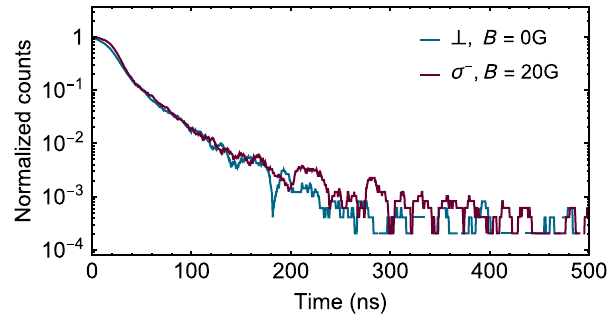
FIG. 8. Photon-count decay with a linear polarization, no magnetic field, and no optical pumping, i.e., multilevel situation (blue). The same is shown for the two-level case: 20-G magnetic field, σ − polarization, and prior optical pumping (purple). The two traces have been normalized to the steady state, with measurements for N ≃ 4500 in the first trapping geometry (see Appendix D).